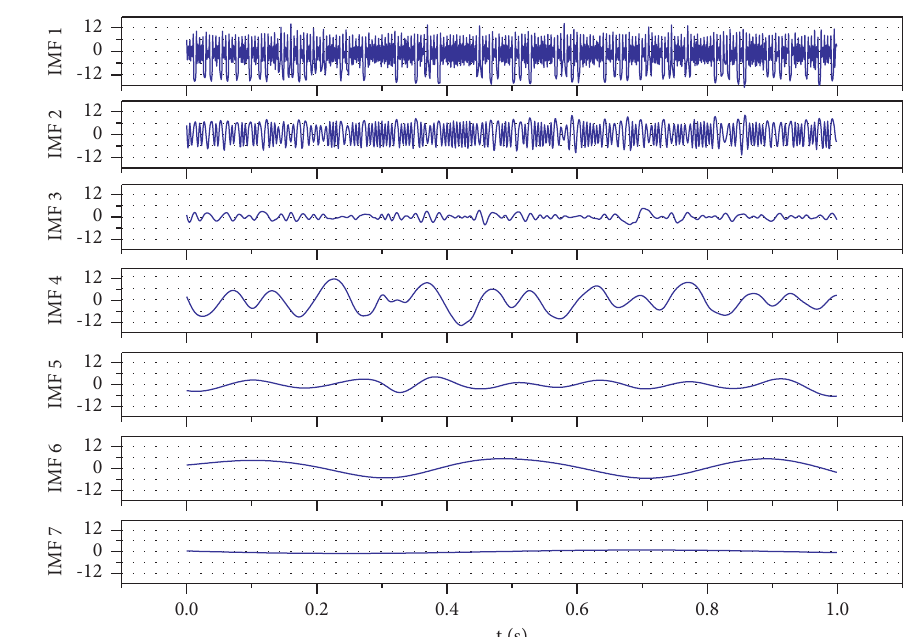
Figure 5: IMFs decomposed from building vibration signal using